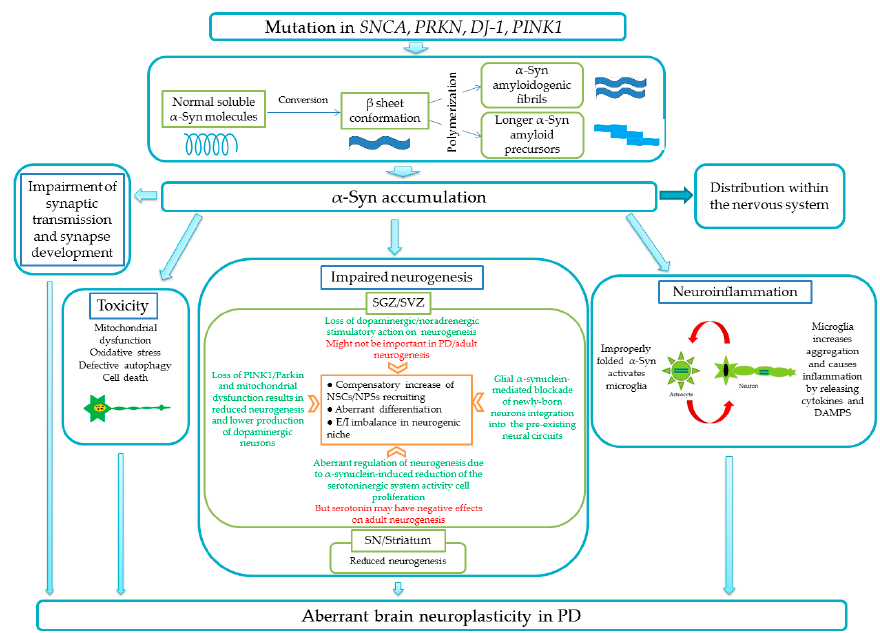
Figure 2. Impairment of brain plasticity in PD caused by the accumulation of α -synuclein in the brain tissue. Aberrant neurogenesis in SGZ/SVZ as well as in the substantia nigra /striatum is a result of numerous mechanisms triggered by improperly folded α -synuclein ( α -syn) that are associated with neuroinflammation, direct cell toxicity, and synaptic